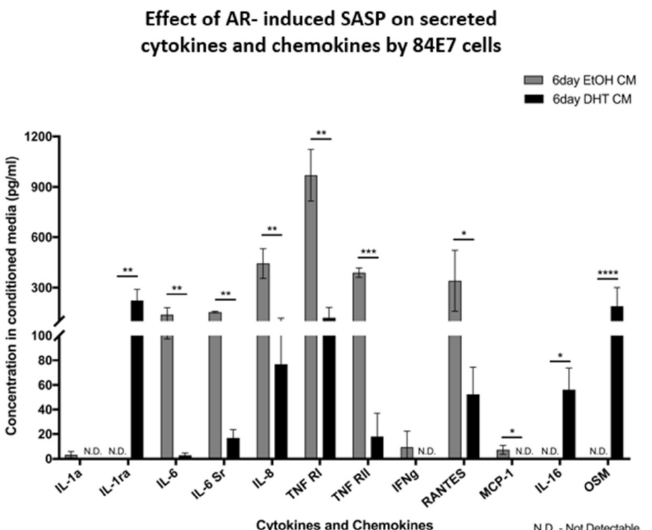
Figure 10. Senescence-associated secretory profile (SASP) of AR-activated 84E7 cells. Quantifi- cation of cytokines and chemokines in the conditioned medium showed significant suppression of inflammatory cytokines IL-6, IL-6Sr, IL-8, TNF, chemokine RANTES, and MCP-1, and an in- crease in anti-inflammatory cytokine IL-1ra, revealing a non-inflammatory SASP (* p -value < 0.05, ** p -value <0.005, *** p -value < 0.0005, **** p -value <